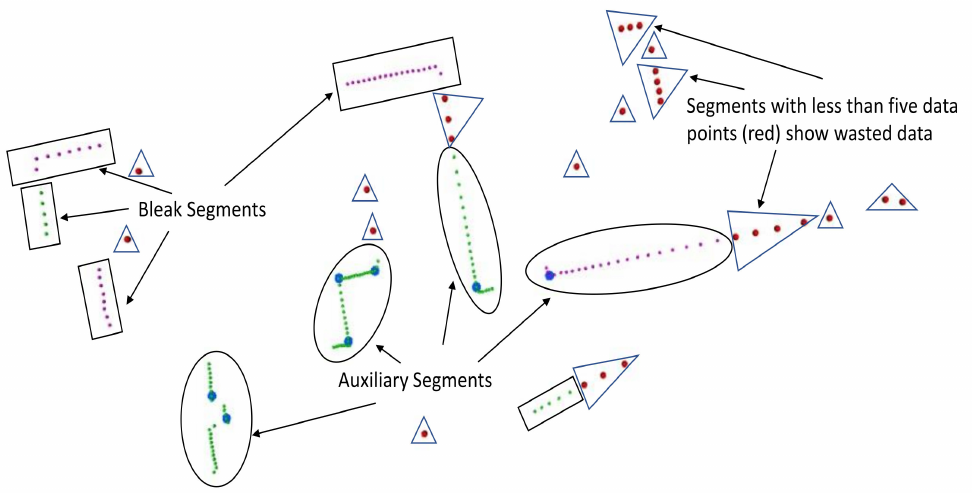
Figure 5. An SVED segmentation-based approach containing the Bleak segment (purple datapoints with no interest points in blue) and auxiliary segments (with associated Interest points in blue color) where the wasted data points are shown in red. The BID-based interest point detection approach was used to detect corners (shown in